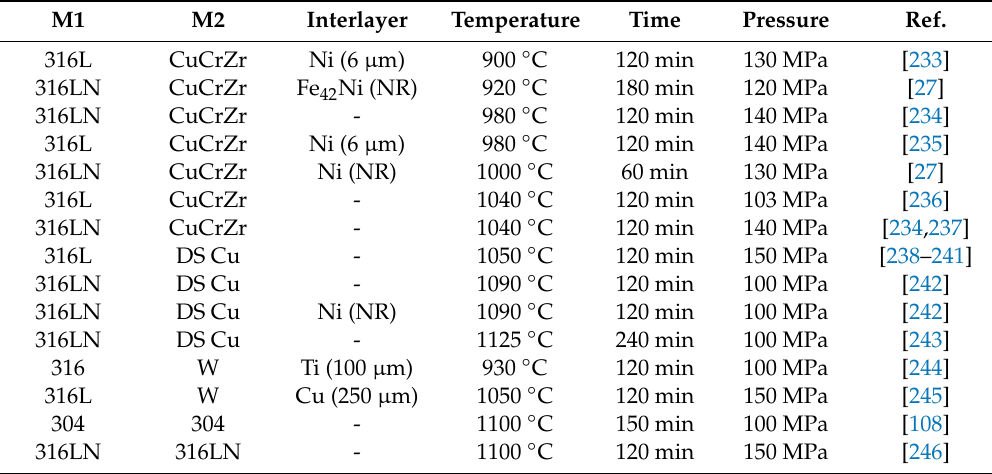
Table 10. Reported parameters for hot isostatic pressing (HIP) of 304 and 316 (similar and dissimilar joints). M1 M2